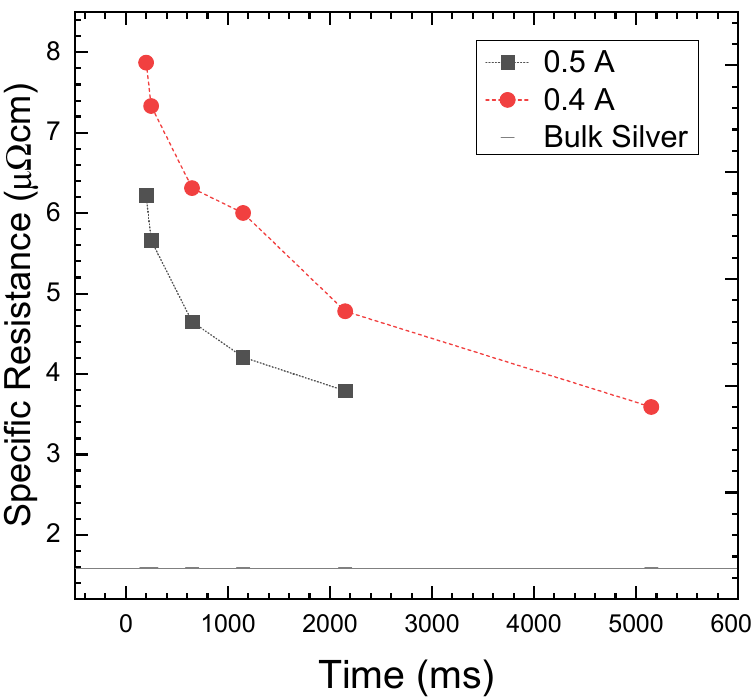
Figure 5. Specific resistance vs. time plot for 0.5 A and 0.4 A final-step currents.